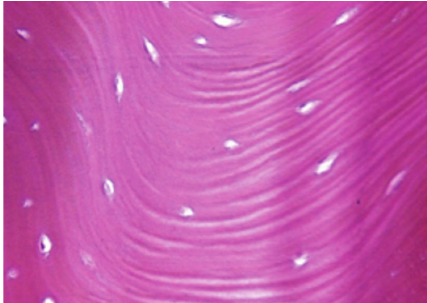
Figure 6: TP: the flap being removed, surface smoothing is engaged.